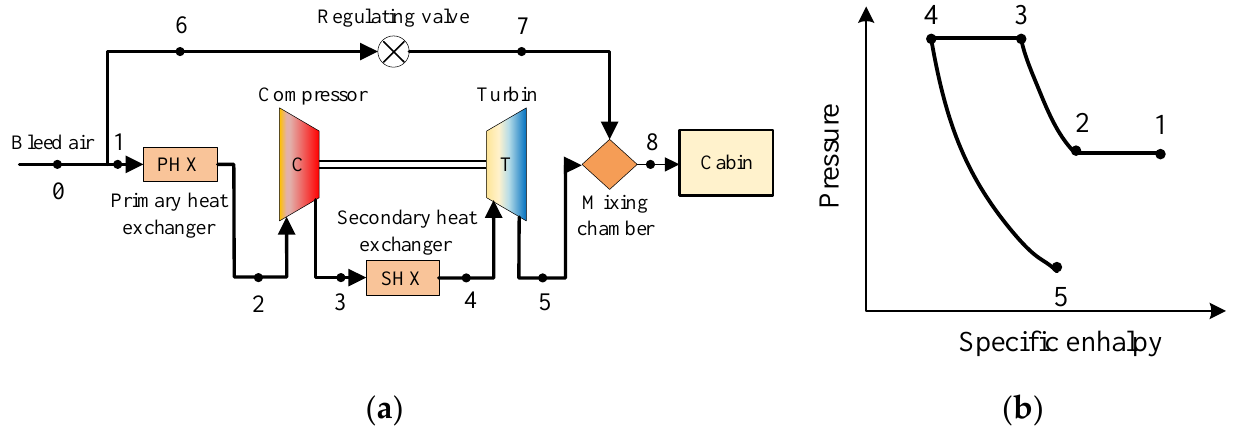
Figure 10. Schematic diagram and pressure–enthalpy diagram of air cycle refrigeration system. ( a ) Schematic diagram. ( b ) Pressure–enthalpy diagram.